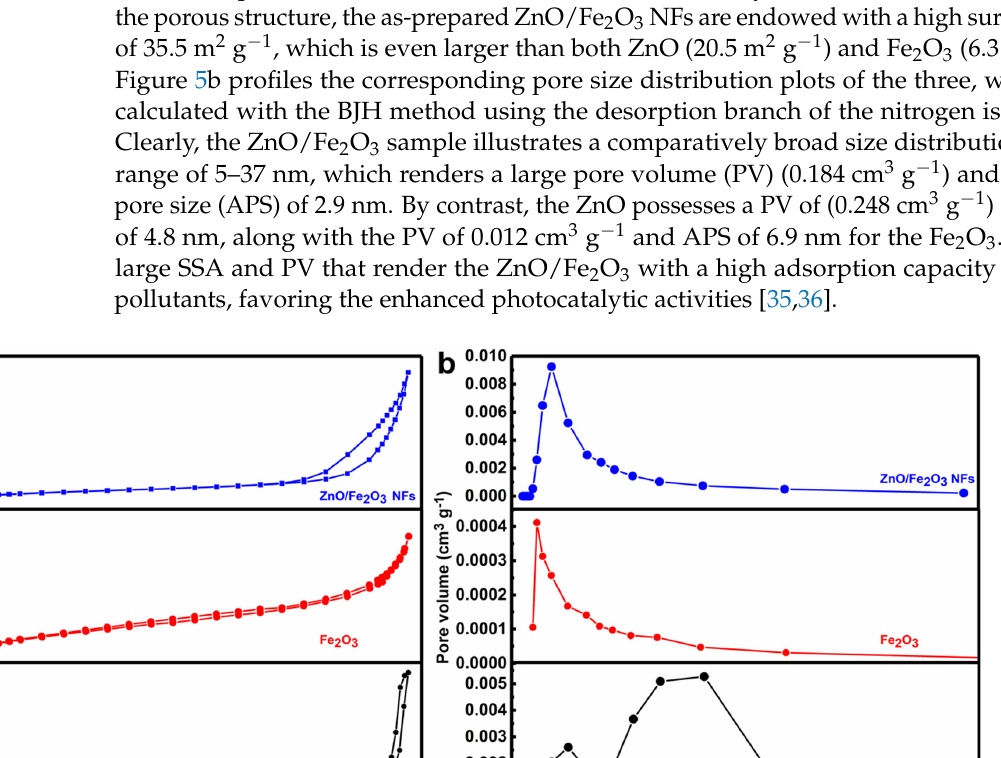
Figure 5. ( a ) N 2 sorption isotherms and ( b ) pore size distribution plots of ZnO/Fe 2 O 3 NFs, Fe 2 O 3 , and ZnO as indicated.